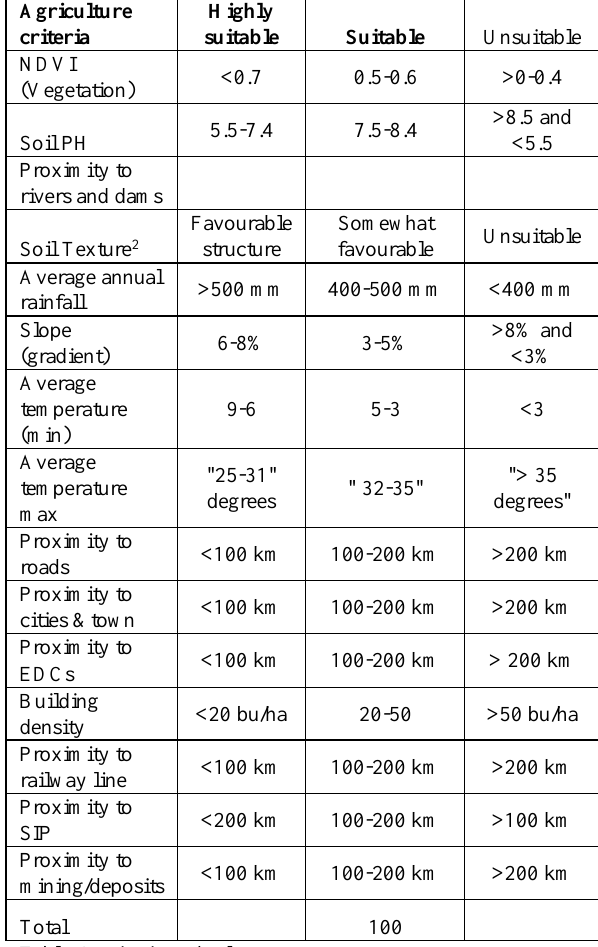
Table 4: criteria and rule sets Accordingly, maps for each criterion were created a